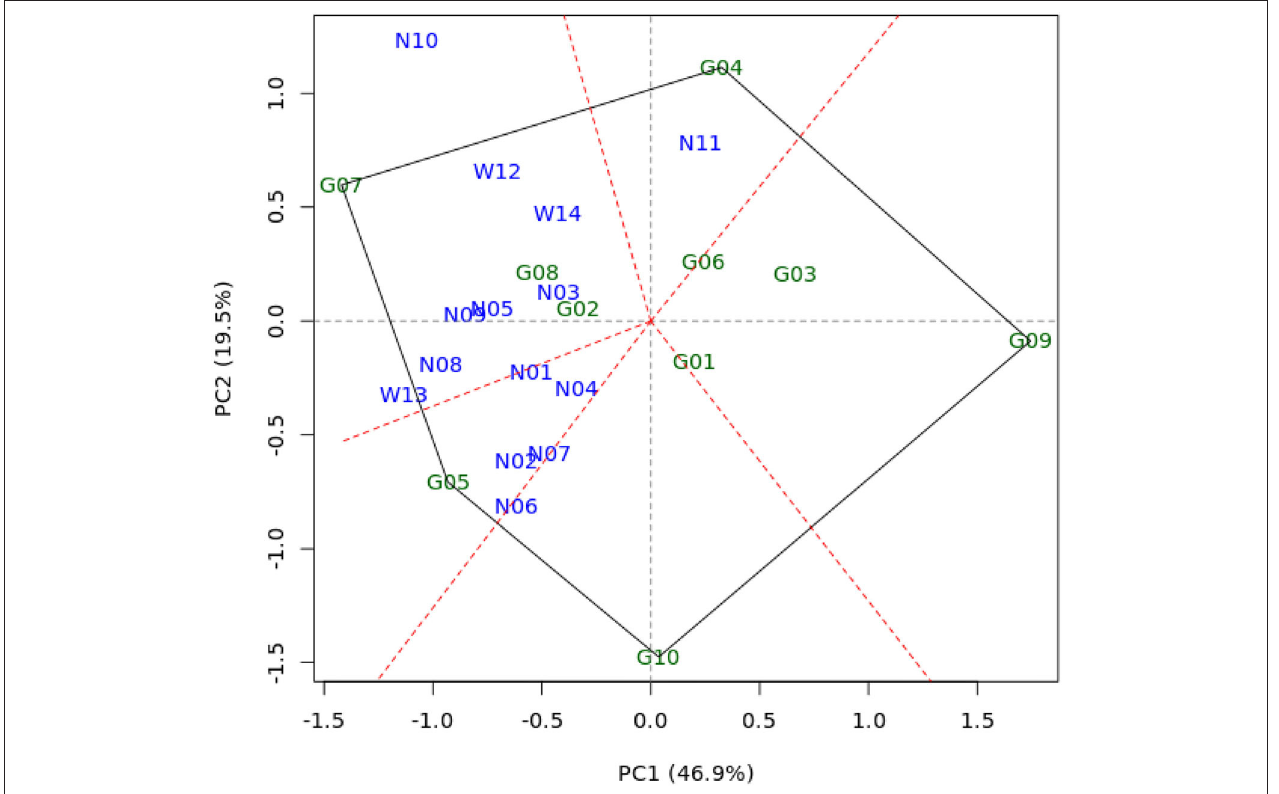
FIGURE 2 | GGE biplot of 10 maize genotypes on yield evaluated in 14 test environments.